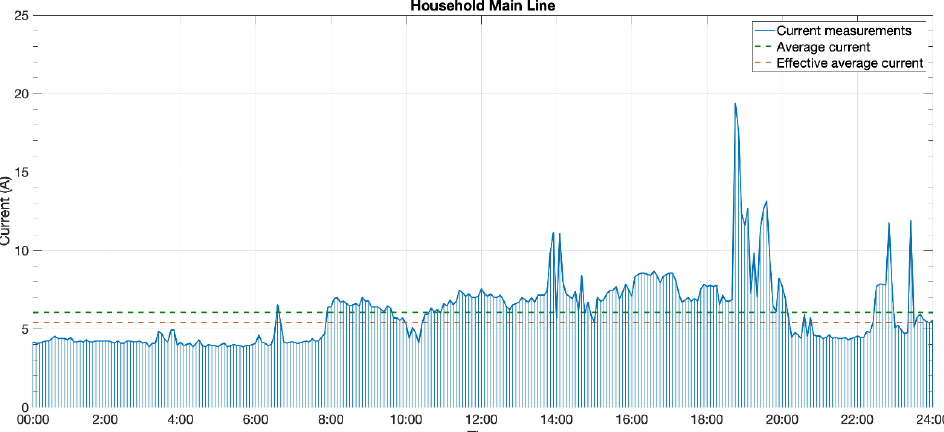
Figure 20. A day of current consumption in the third test scenario.